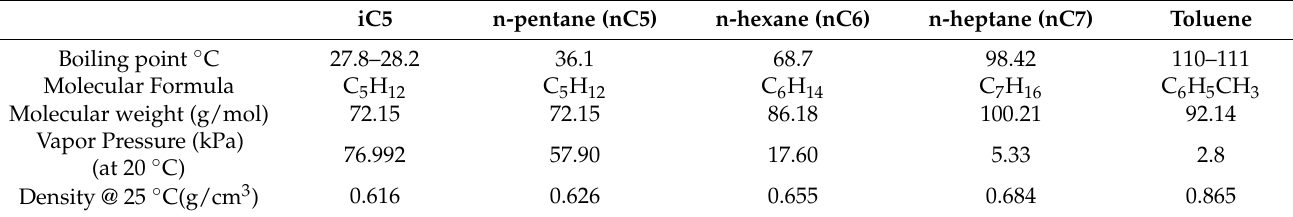
Table 1. Properties of isopentane, n-pentane, n-hexane, n-heptane, and toluene using in stationary